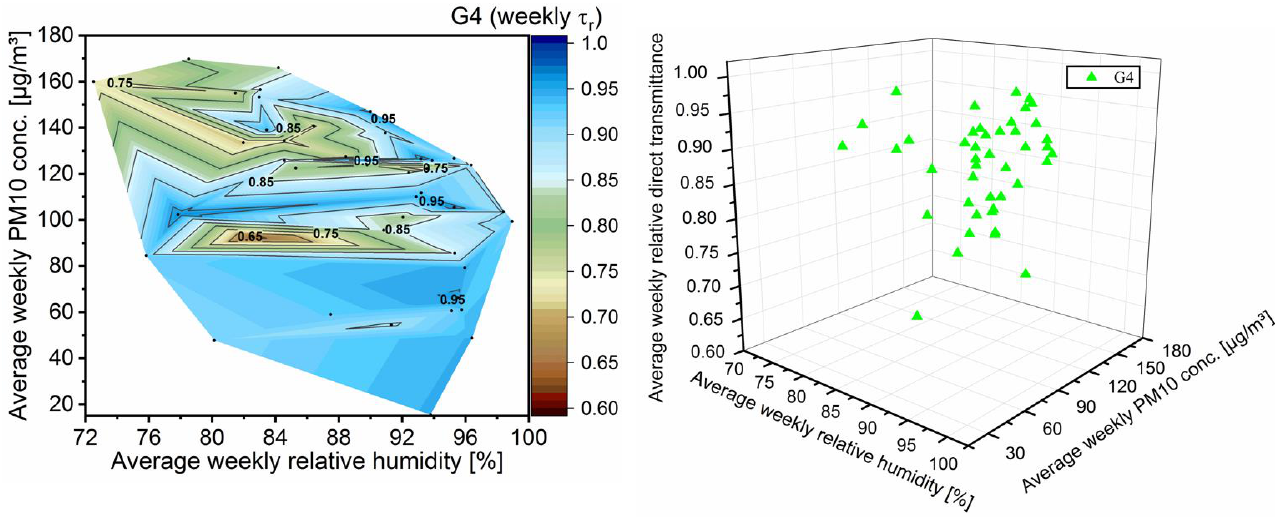
Figure 9. Correlation between the average relative direct transmittance ( τ r ), the average weekly PM10 , and relative humidity ( RH ) for the never cleaned (G4) glass coupon. The figure on the right shows the scatter plot for data on the left.